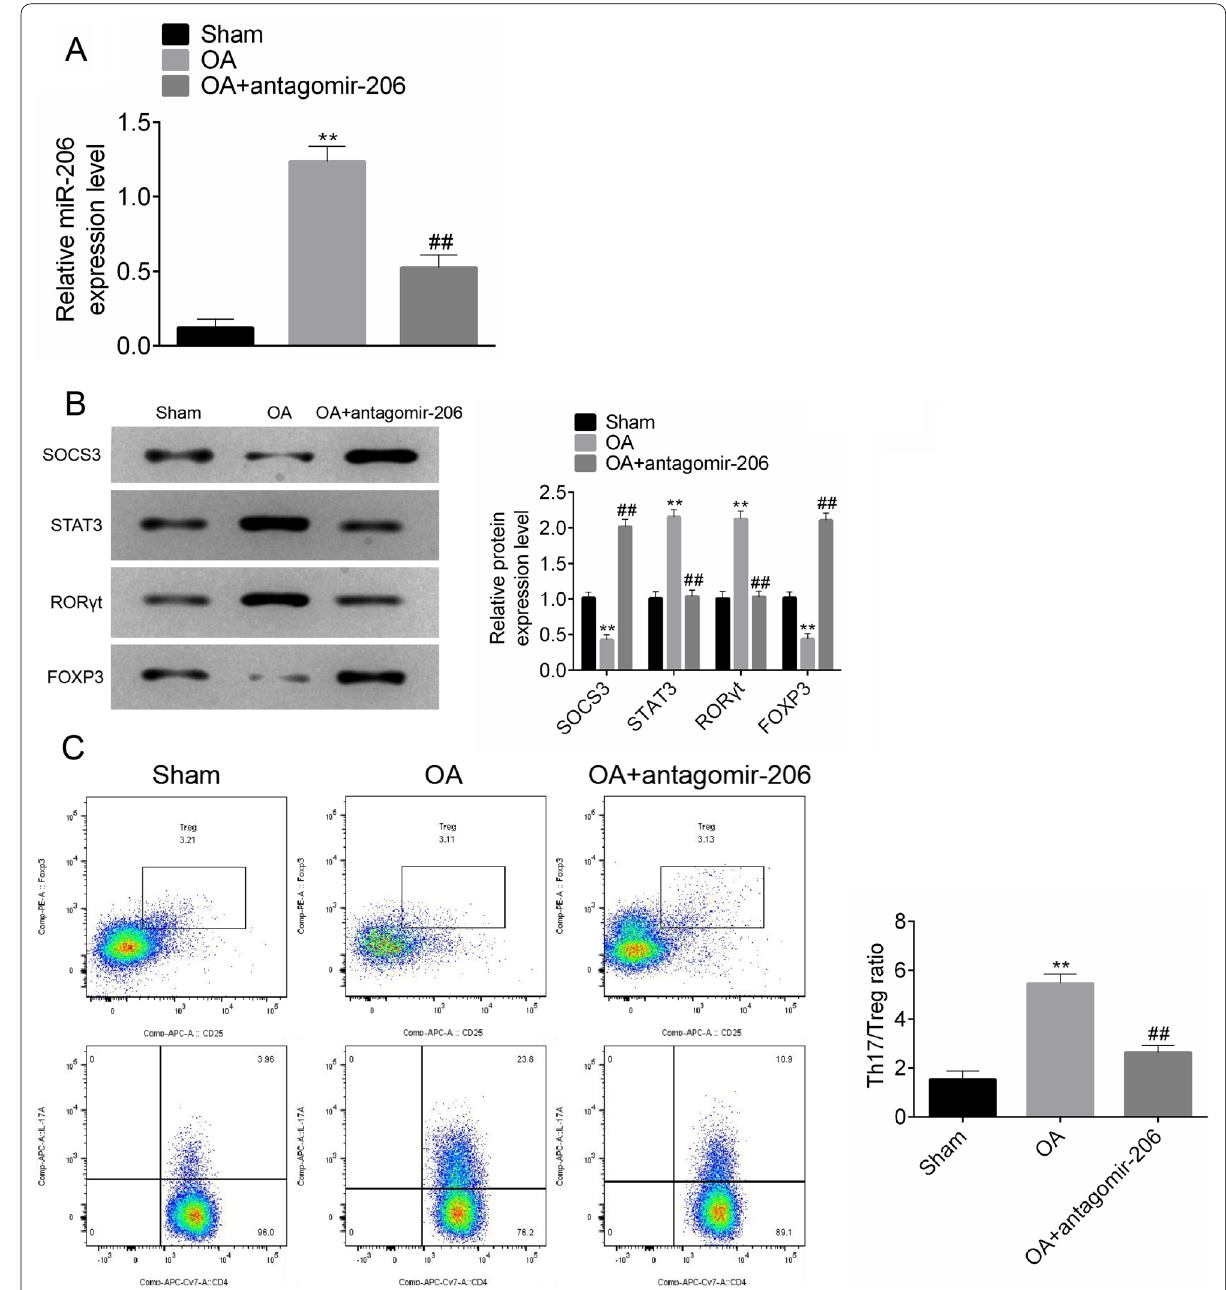
Fig. 4 Inhibition of miR-206 expression restored the balance of Th17/Treg during OA pathogenesis. The expression of miR-206 ( A ), SOCS3, Foxp3, STAT3, RORγt ( B ), and Th17/Treg ratio ( C ) in rats with different groups. All experiments were repeated three times. Data are expressed as mean ** P < 0.01; ## P <